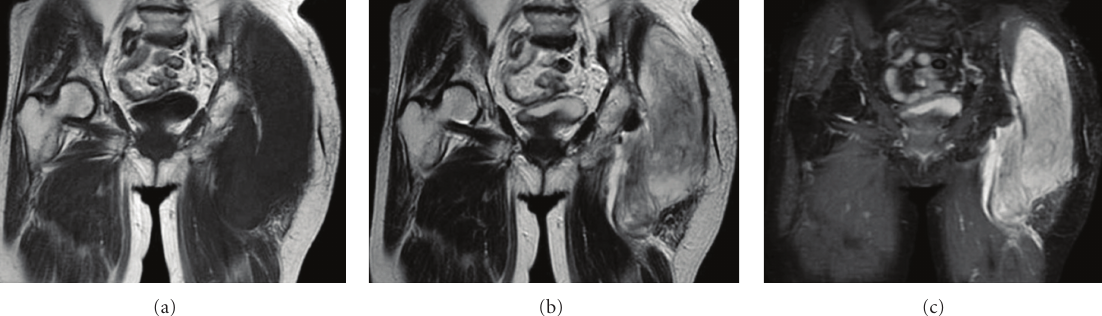
Figure 1: Magnetic resonance images of the left buttock. (a) T1-weighted, (b) T2-weighted, and (c) T2-STIR MR images demonstrated a multilobular intermuscular mass.